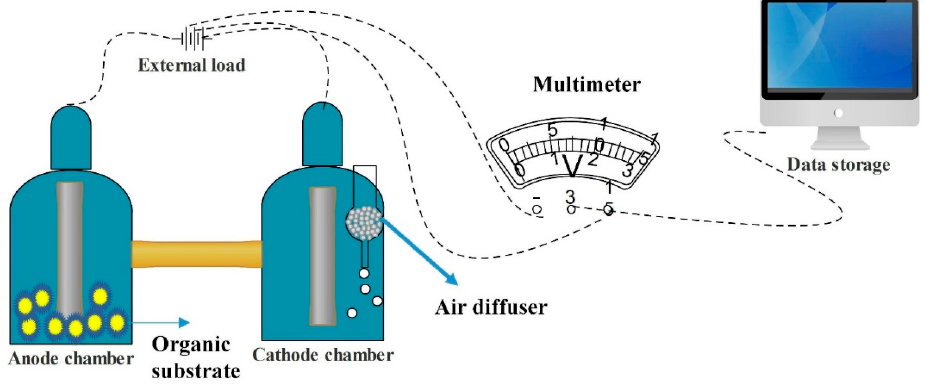
Figure 1. General prototype scheme of a benthic microbial fuel cell.